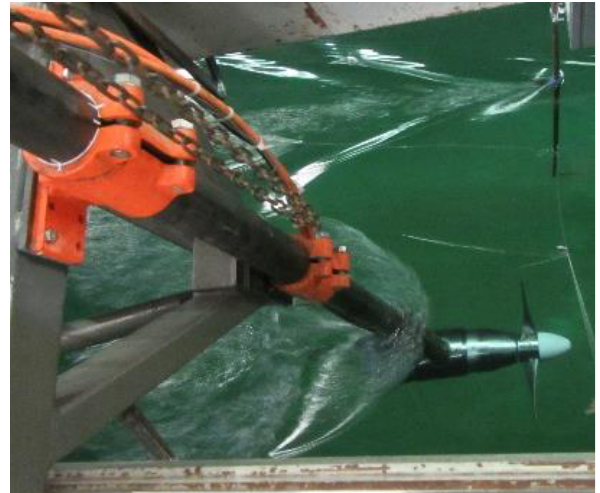
Figure 3. Turbine installed at the tow tank at CNR-INSEAN